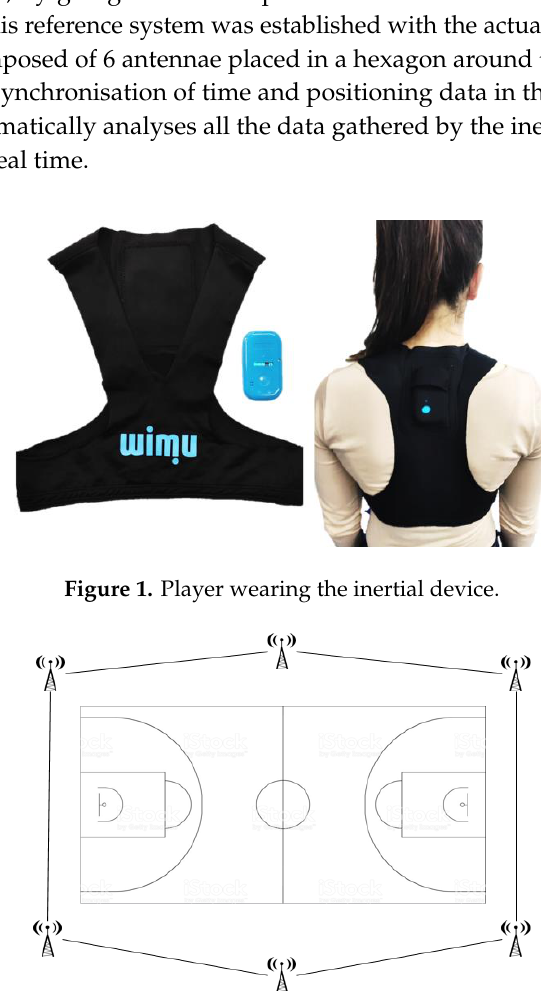
Figure 2. UWB system on basketball court.